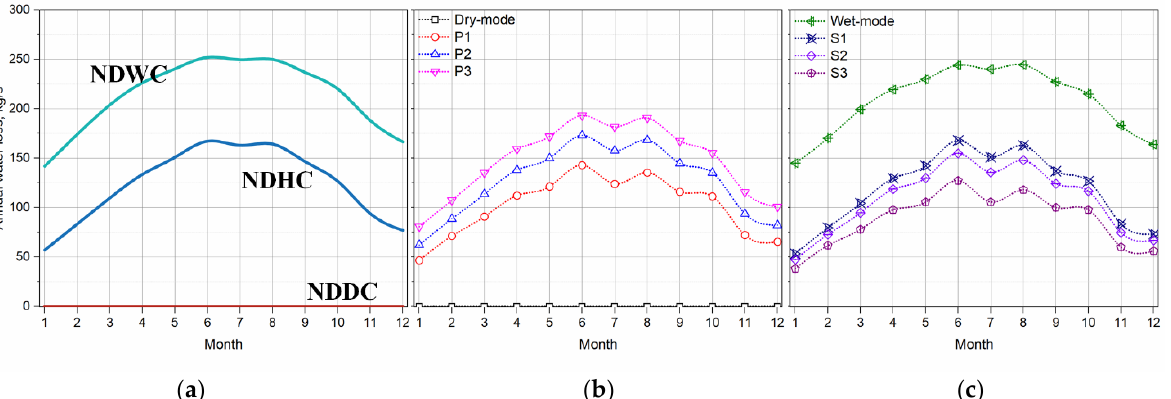
Figure 12. Annual water consumption of cooling systems when coupling with the thermal cycle. ( a ) NDDC, NDWC and NDHC, ( b ) parallel mode of NDHC, ( c ) serial mode of NDHC.